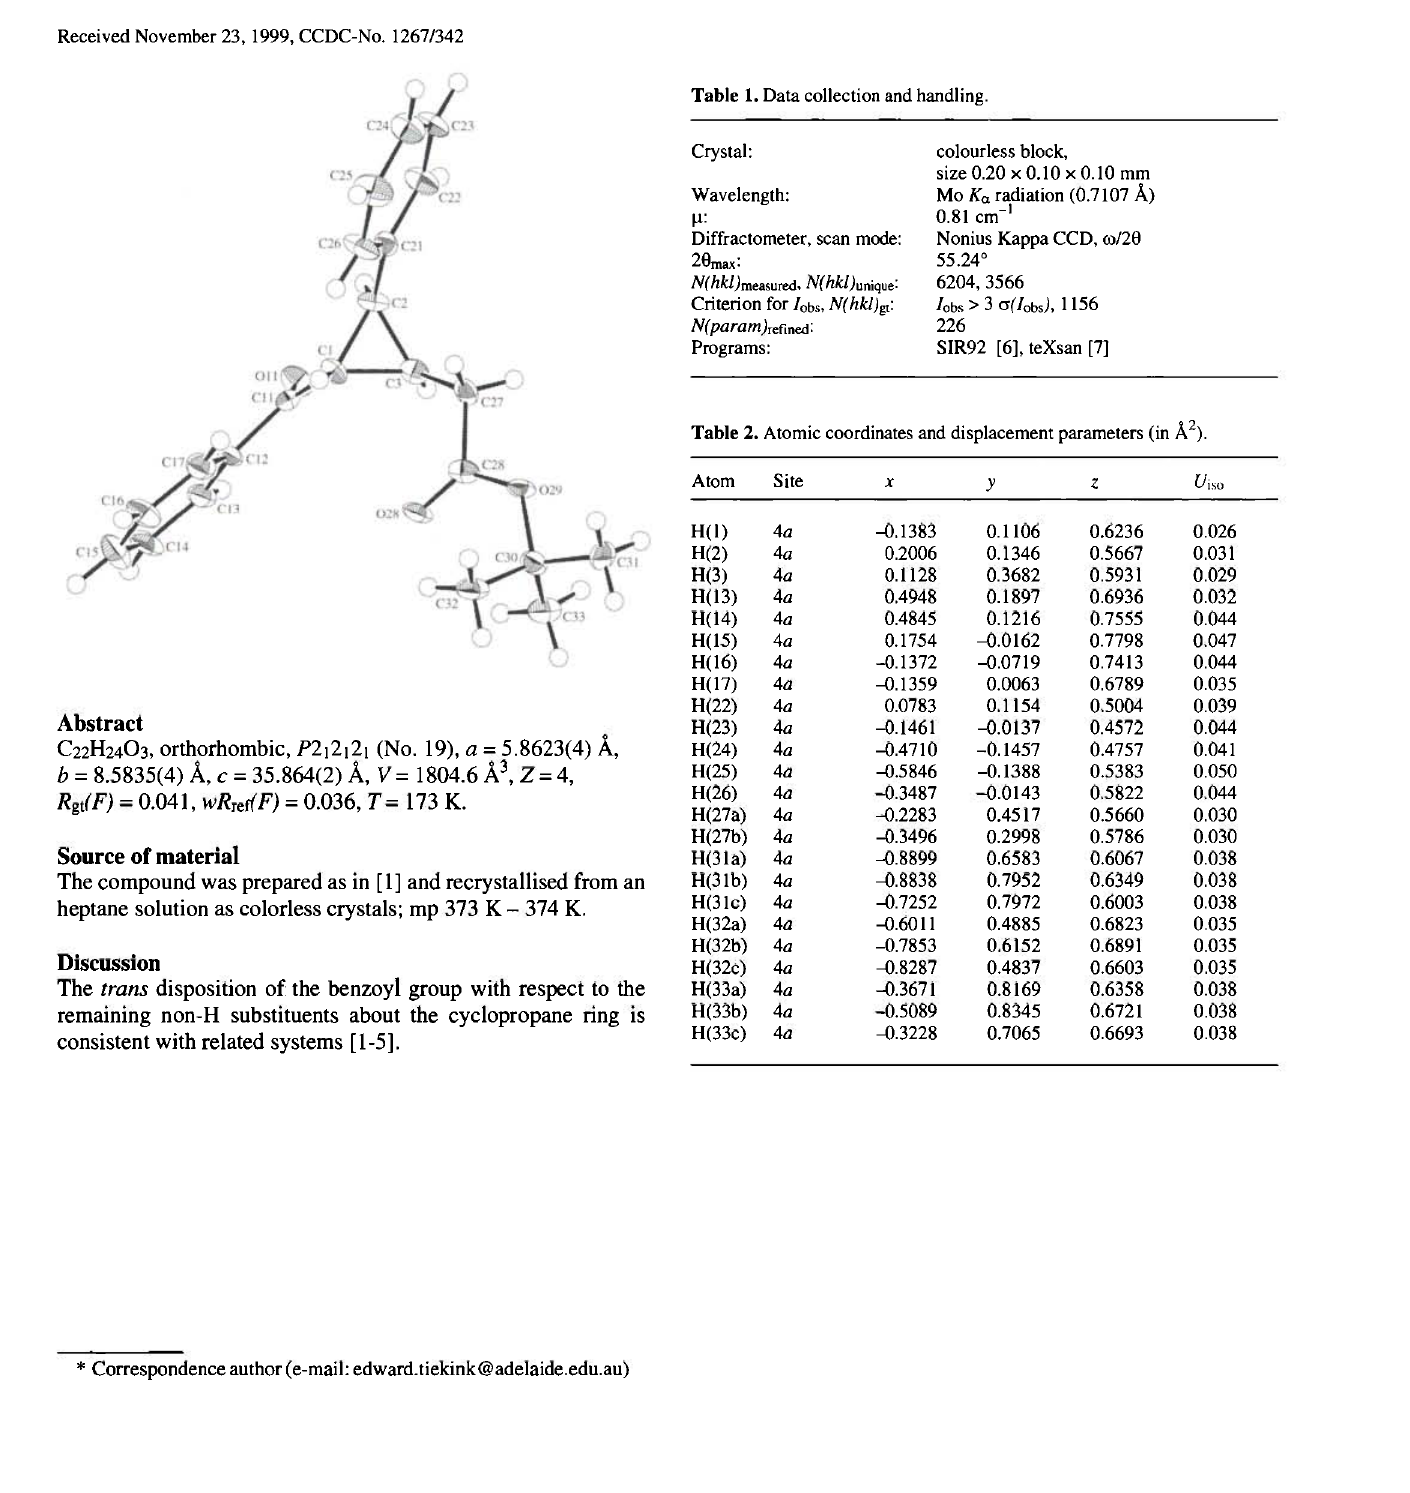
Table 1. Data collection and handling.